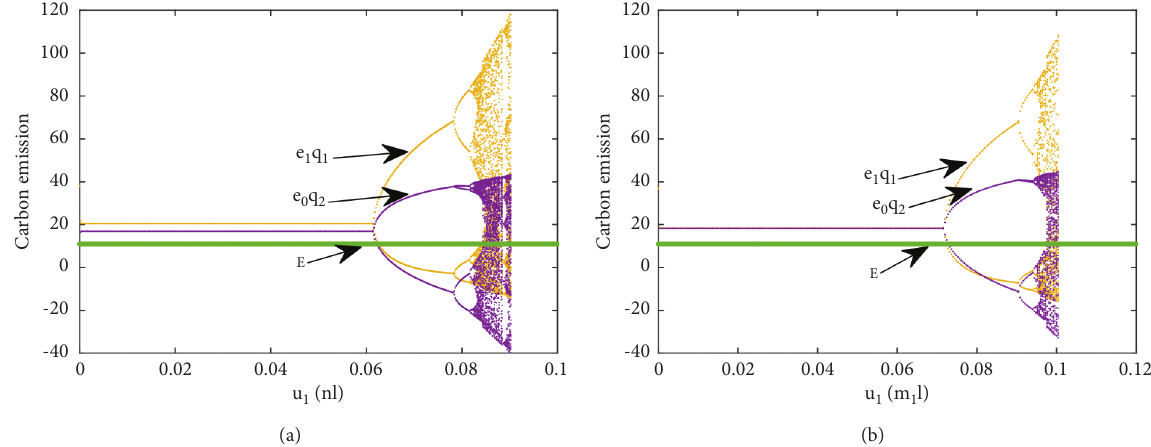
Figure 10: Change of carbon emission with varying u